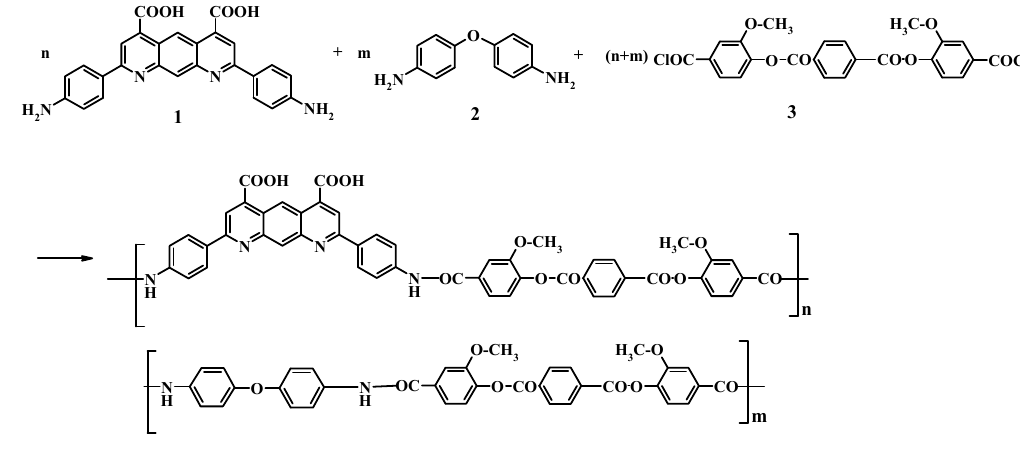
Figure 1. The scheme of copolyamide (coPA) synthesis.